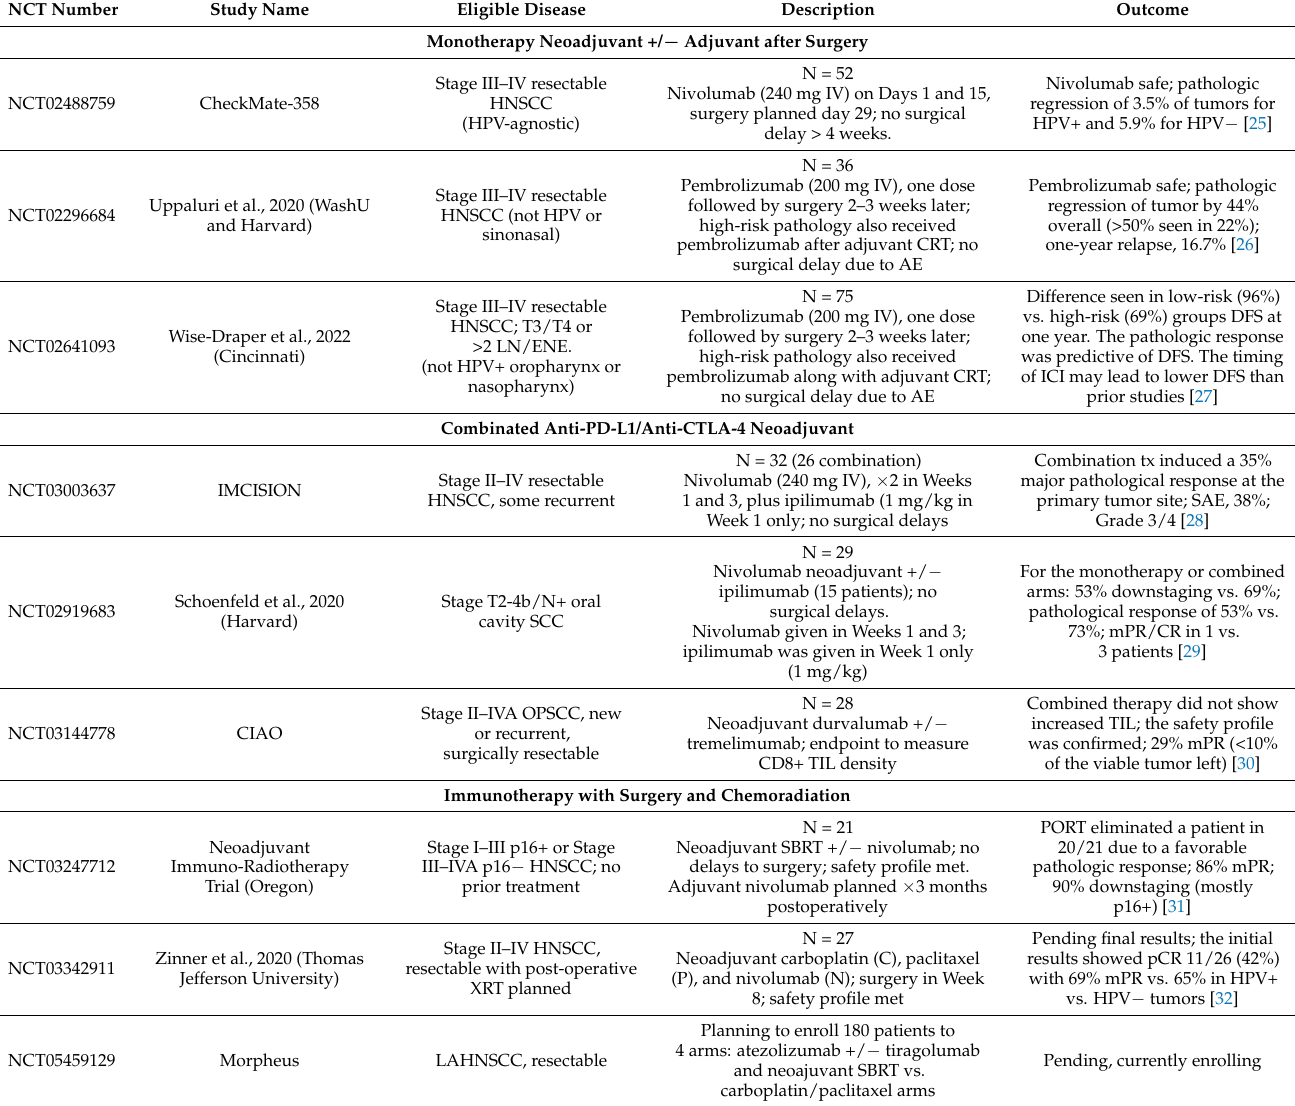
Table 1. Selected Phase I/II clinical trials of neoadjuvant ICI prior to surgery for locally advanced